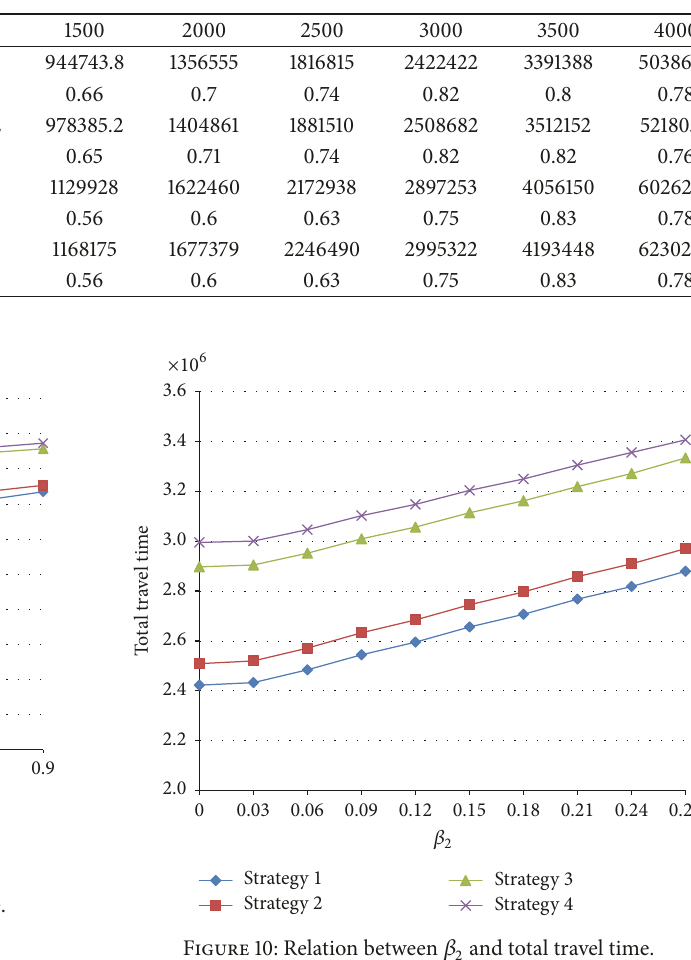
Table 3: Total travel time and travel ratio of AVs under different travel demand.